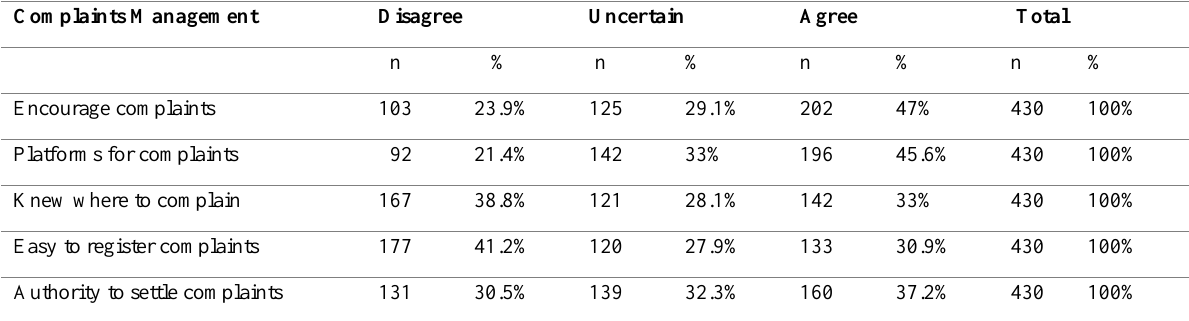
Table 3: Frequency distribution of complaints